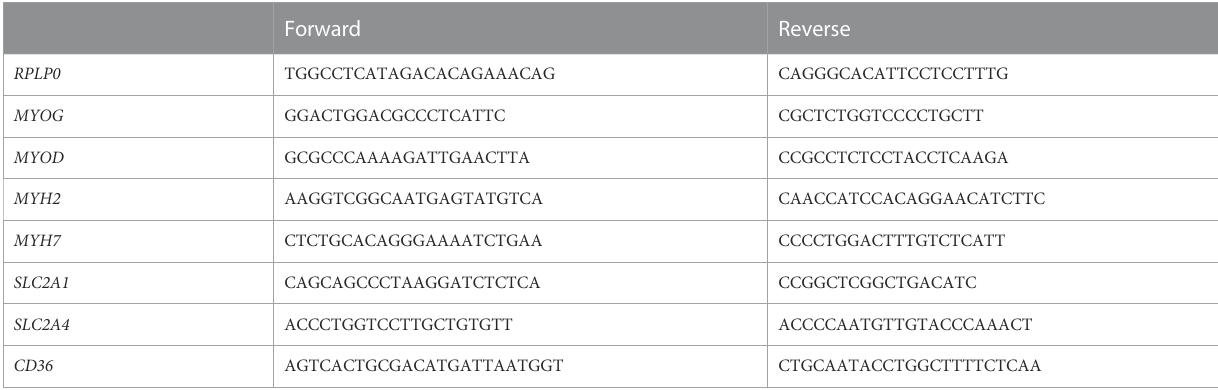
TABLE 2 Primer ’ s